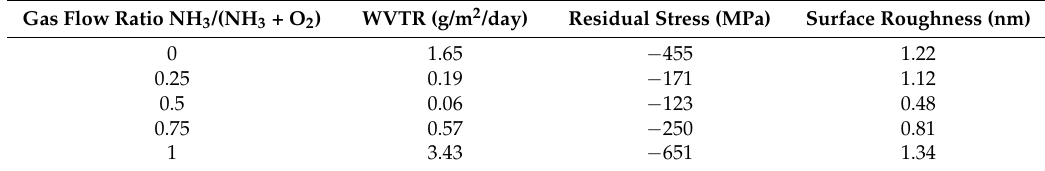
1 Measurements taken at 40 °C with 95% RH.